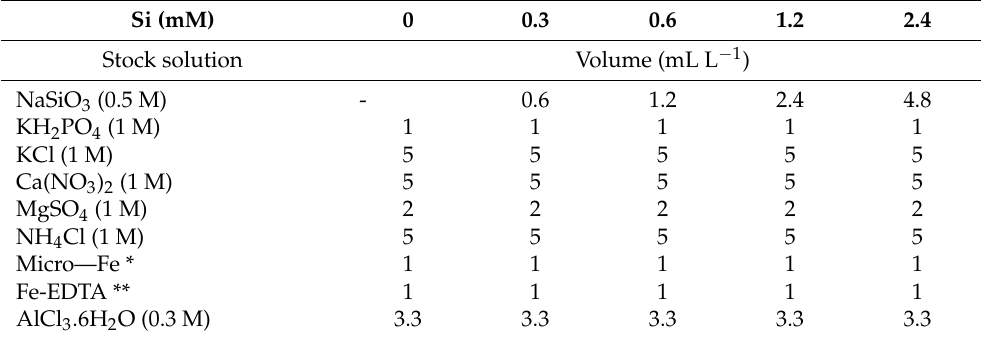
Table 1. Volumes of stock solutions used in preparation of nutrient solutions provided during the